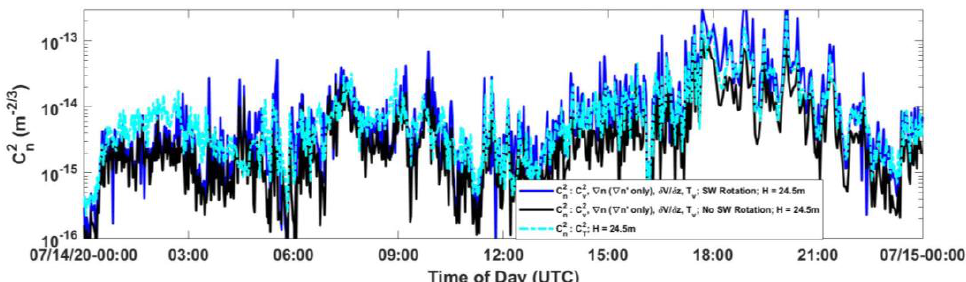
Figure 6. Profiles of C n2 at 24.5 m above the surface after applying streamwise (SW) triple rotation scheme about the sonic anemometer’s “u”, “v”, and “w” coordinate system.